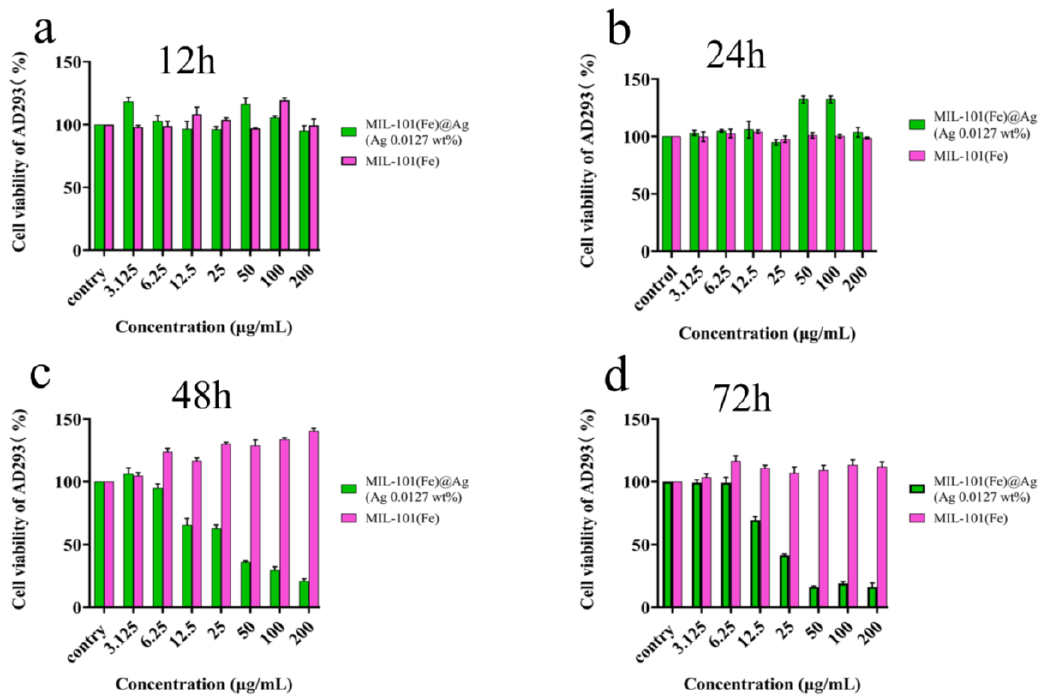
Figure 15. Survival rate of MIL-101(Fe)@Ag -treated AD293 cells after 12 h ( a ), 24 h ( b ), 48 h ( c ), and 72 h ( d ). The hemolytic behavior of MIL-101(Fe)@Ag (Ag 0.0127 wt%) was also investigated to assess its biocompatibility. In general, hemoglobin is released via the disruption of the red-blood-cell membrane, thus allowing hemolysis to occur. MIL-101(Fe)@Ag (Ag 0.0127 wt%) did not produce severe hemolytic effects on chicken erythrocytes, even as the concentration of MIL-101(Fe)@Ag (Ag 0.0127 wt%) increased (Figure 16). Similar to the results of the cytotoxicity assay, the results of hemolysis analysis showed that high doses of MIL-101(Fe)@Ag (Ag 0.0127 wt%) did not cause severe hemolytic effects [61,62].